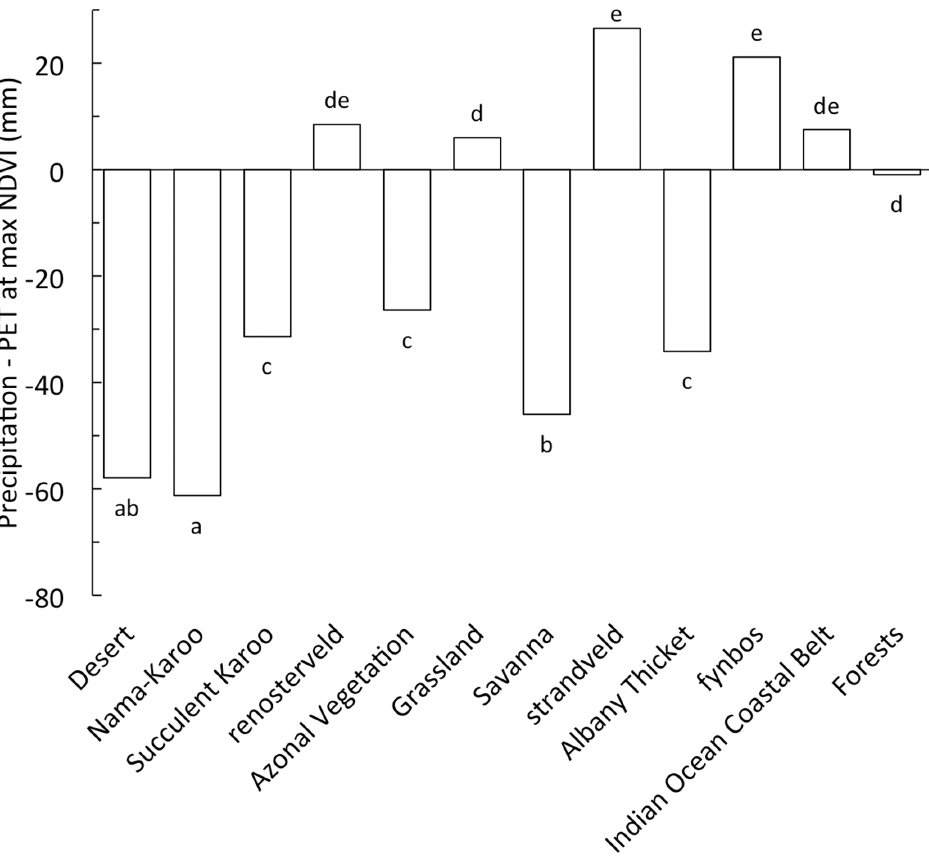
Fig 6. Water availability measured as the average of monthly precipitation — potential evapotranspiration (P-PET) for the vegetation types in the month when annual NDVI was maximal. A positive value indicates that precipitation exceeded potential evaporation when NDVI was maximal. Different letters indicate significant (P < 0.05) differences between vegetation types as determined by one-way ANOVA followed by post-hoc Tukey tests. Vegetation types are arranged in order of increasing